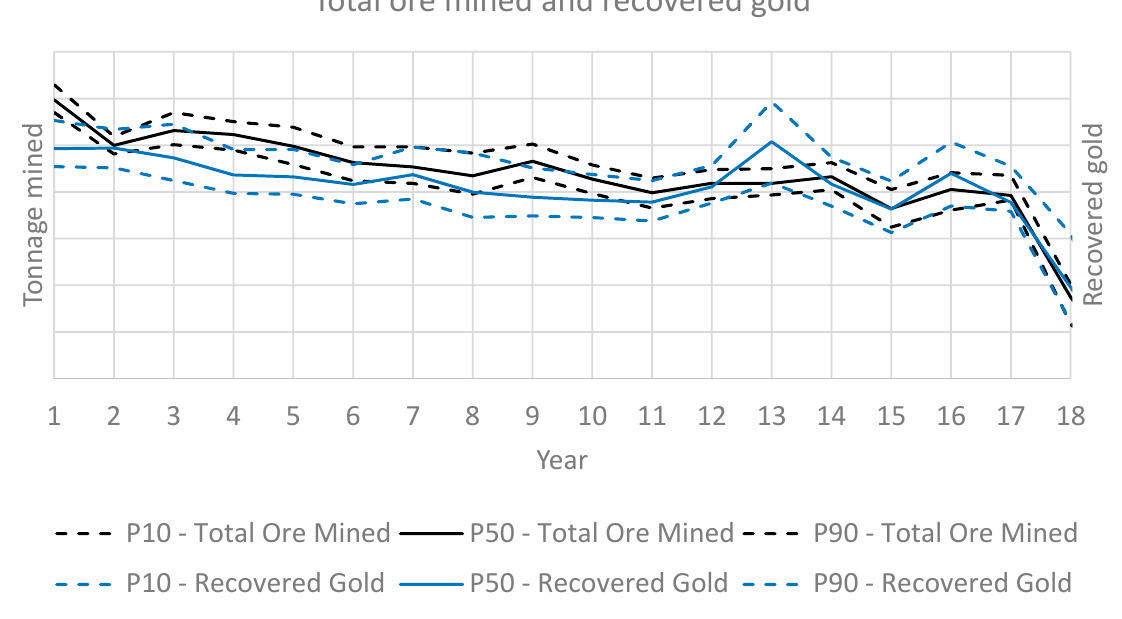
Figure 3. Total ore tonnage mined and recovered gold from the three mines at the RGM mining complex.